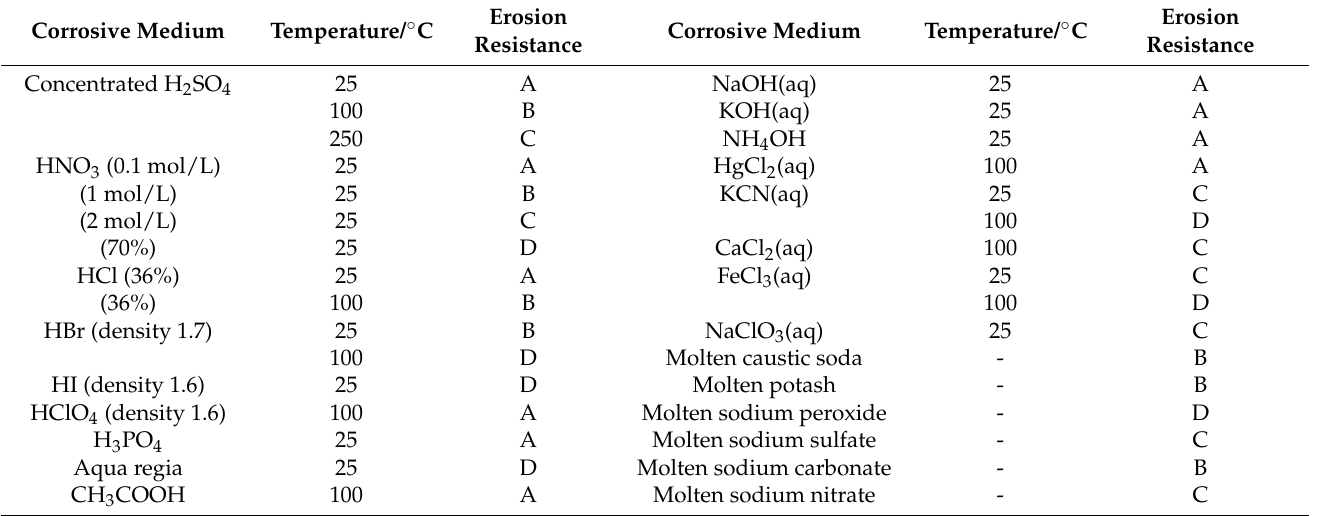
A—no corrosion; B—slight corrosion; C—corrosion; D—serious corrosion.